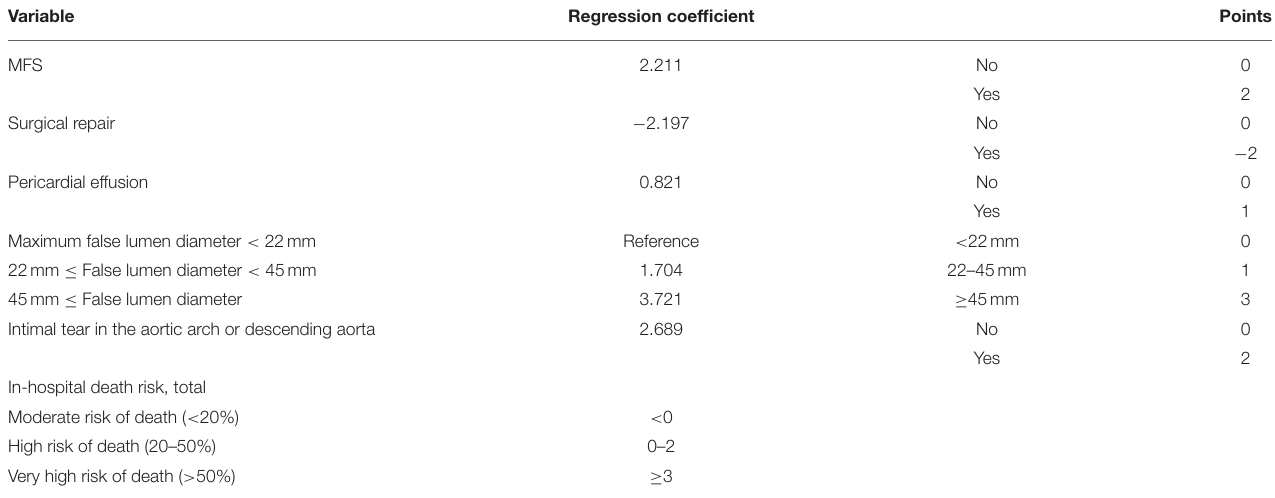
TABLE 3 | Three-level type A aortic dissection clinical prognosis score (3ADPS). Variable Regression